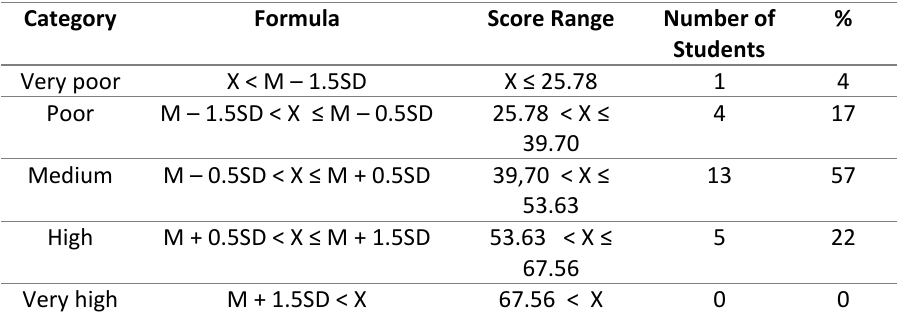
Table 5. Analysis of Ibnu Thufail Students’